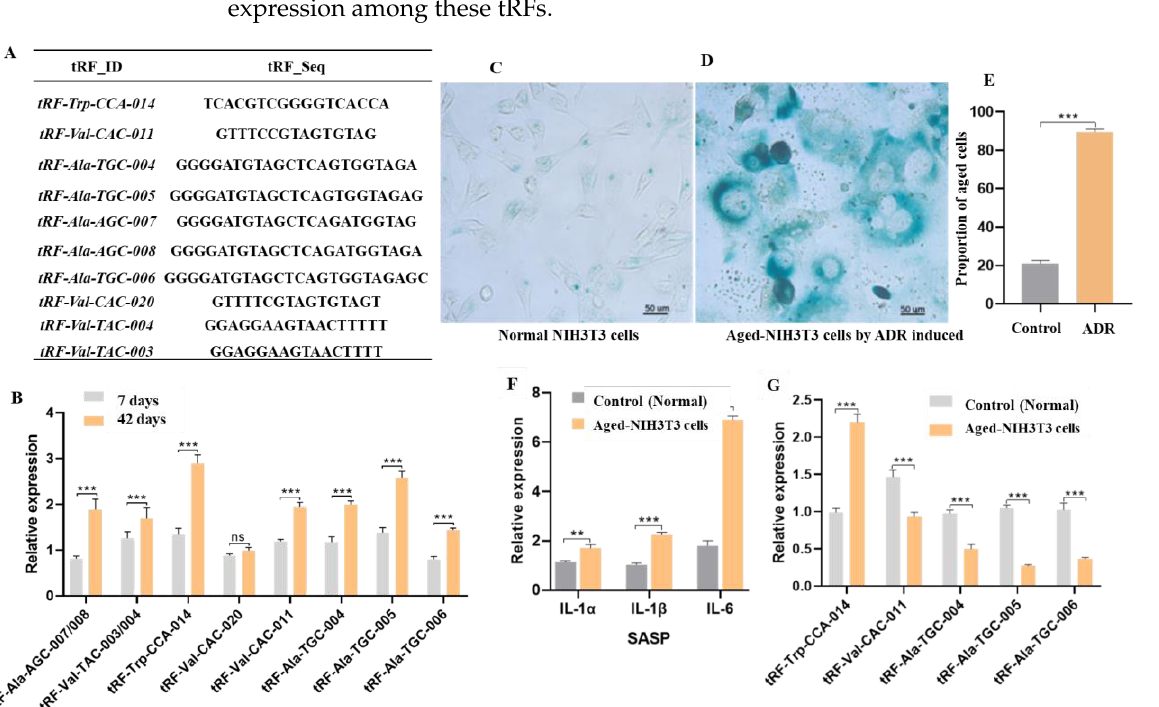
Figure 2. Verification of 10 differentially expressed tRFs in Drosophila and aged mouse NIH3T3 cells. ( A ) The sequences of 10 differentially expressed tRFs; ( B ) the expression levels of 10 differentially expressed tRFs of Drosophila at 7 days and 42 days; ( C ) β -gal staining of normal mouse NIH3T3 cells without adriamycin (ADR); ( D ) β -gal staining of aged mouse NIH3T3 cells induced by ADR; ( E ) the number of β -gal-stained cells in normal and aged mouse NIH3T3 cells. ( F ) the expression levels of IL- 1α , IL- 1β , and IL-6 ; ( G ) 5 tRFs in normal and aged mouse NIH3T3 cells induced by ADR. ADR — adriamycin; SASP — senescence-associated secretory phenotypes; **, p 0.01; ***, p 0.001; ns — no